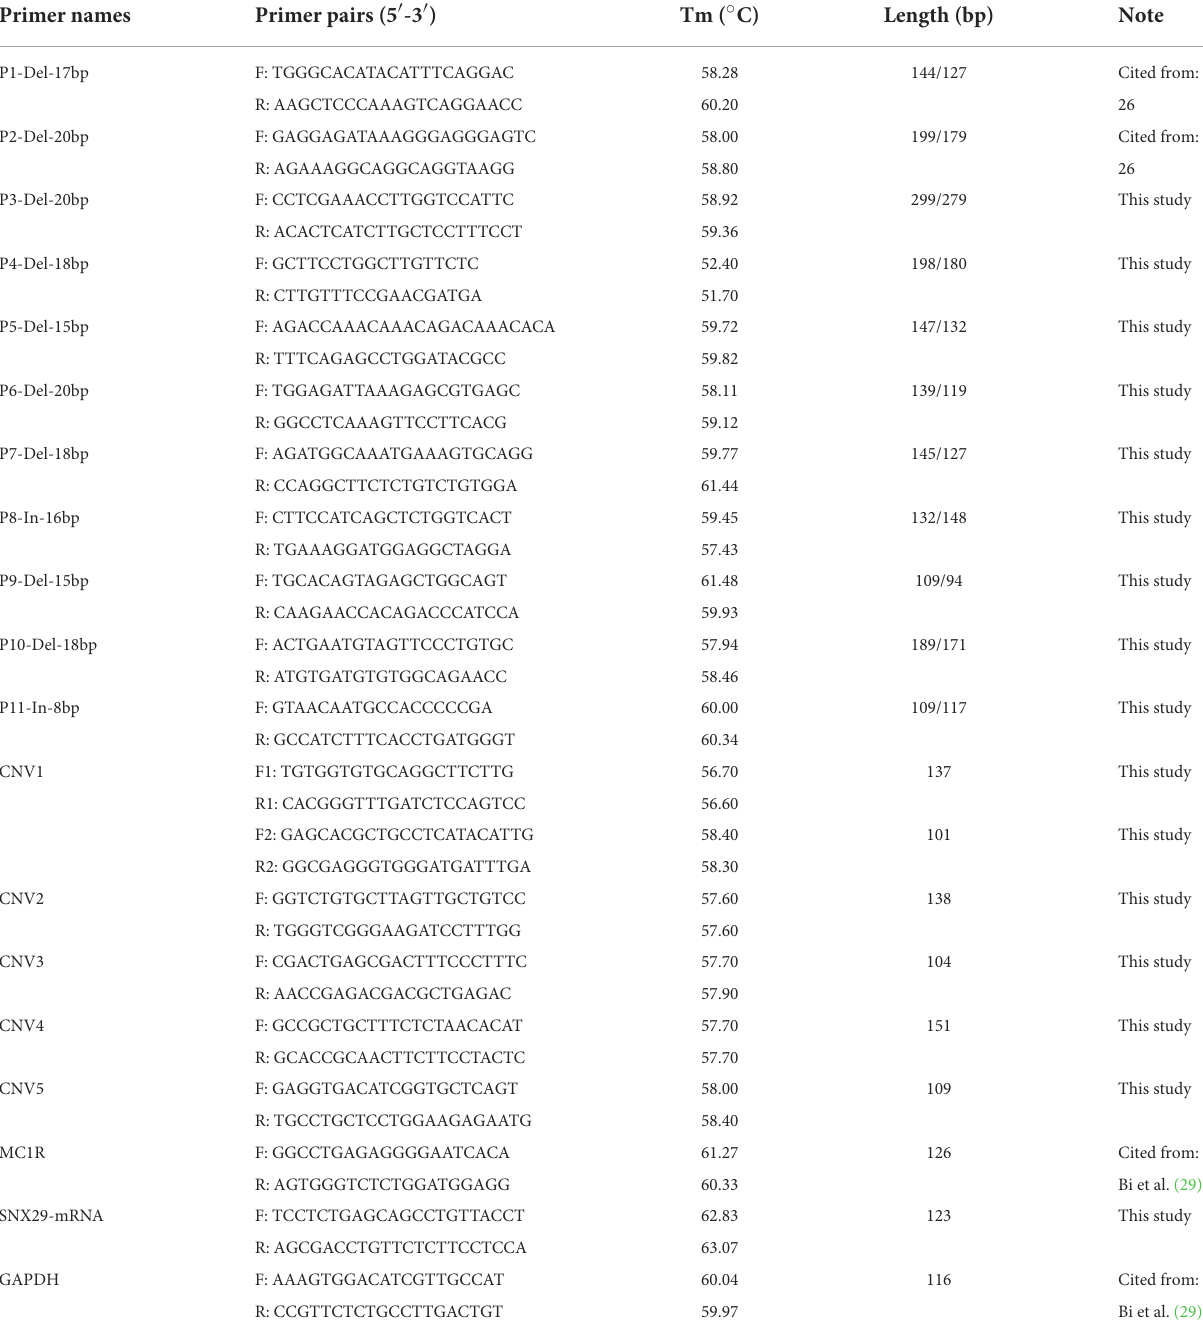
TABLE 1 The primer information of InDel, CNV and mRNA expression. Primer